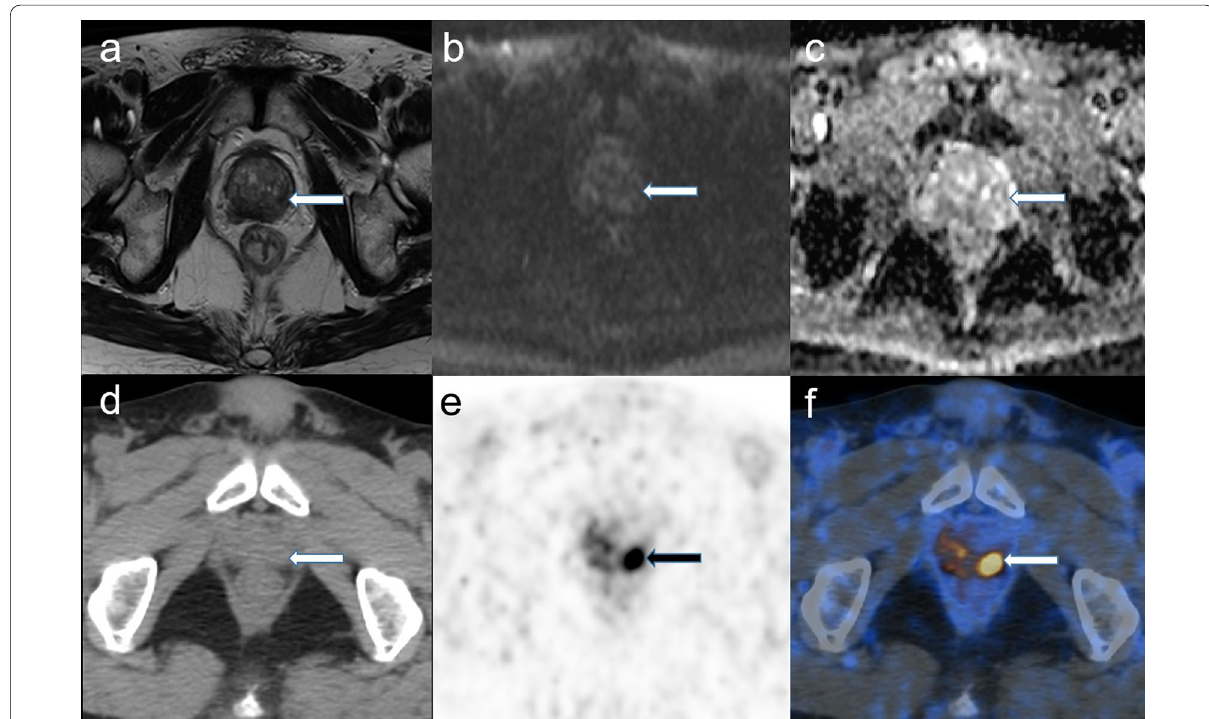
Fig. 4 Low- and intermediate-risk PCa with PSA > 9.4 ng/ml and age > 62.5 years, who are mpMRI ( patient whose serum PSA level was 17.9 ng/ml and whose GS was 3 1500 DWI), while in the 68 Ga-PSMA PET/CT, there is a strong tracer uptake highly likely to be diagnosed (arrow in e and f ). a – c MRI; d – f 68 Ga-PSMA PET/CT; a T2w; b b 1500 DWI; c ADC map; d low-dose CT; e maximum intensity projection of the PET; f fusion of 68 Ga-PSMA PET and low-dose CT